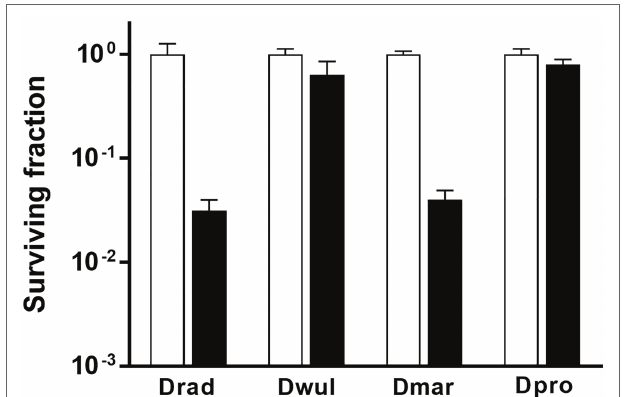
FIGURE 8 | Survival of Deinococcus species with or without BphP in response to MMC. The bphP -positive strains, D. radiodurans (Drad) and D . maricopensis (Dmar), and the bphP -negative strains, D. wulumuqiensis (Dwul) and D . proteolyticus (Dpro), were grown to log phase and spotted on TGY plates supplemented with 300 nM MMC. The plates were incubated under red light (700 nm) or no light (dark) conditions for 2 days prior to the enumeration of colonies. The surviving fraction was calculated by dividing the CFUs of dark-grown cells by the CFUs of light-grown cells. The error bars represent the SD of three independent experiments ( n =